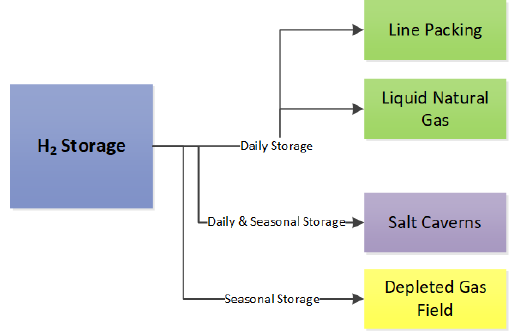
Figure 4. The hydrogen storage alternatives.